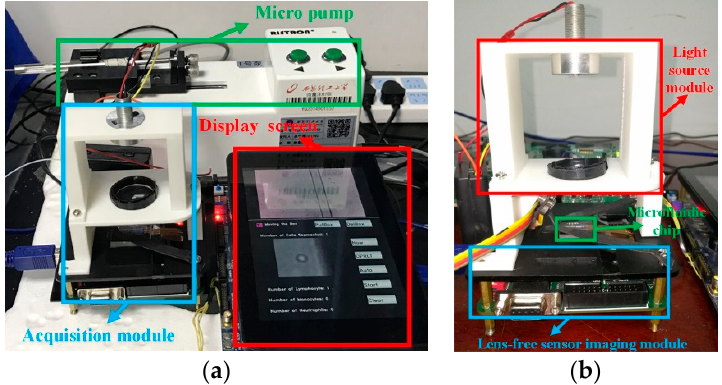
Figure 12. The microfluidic acquisition device ( a ) vertical view ( b ) side view.